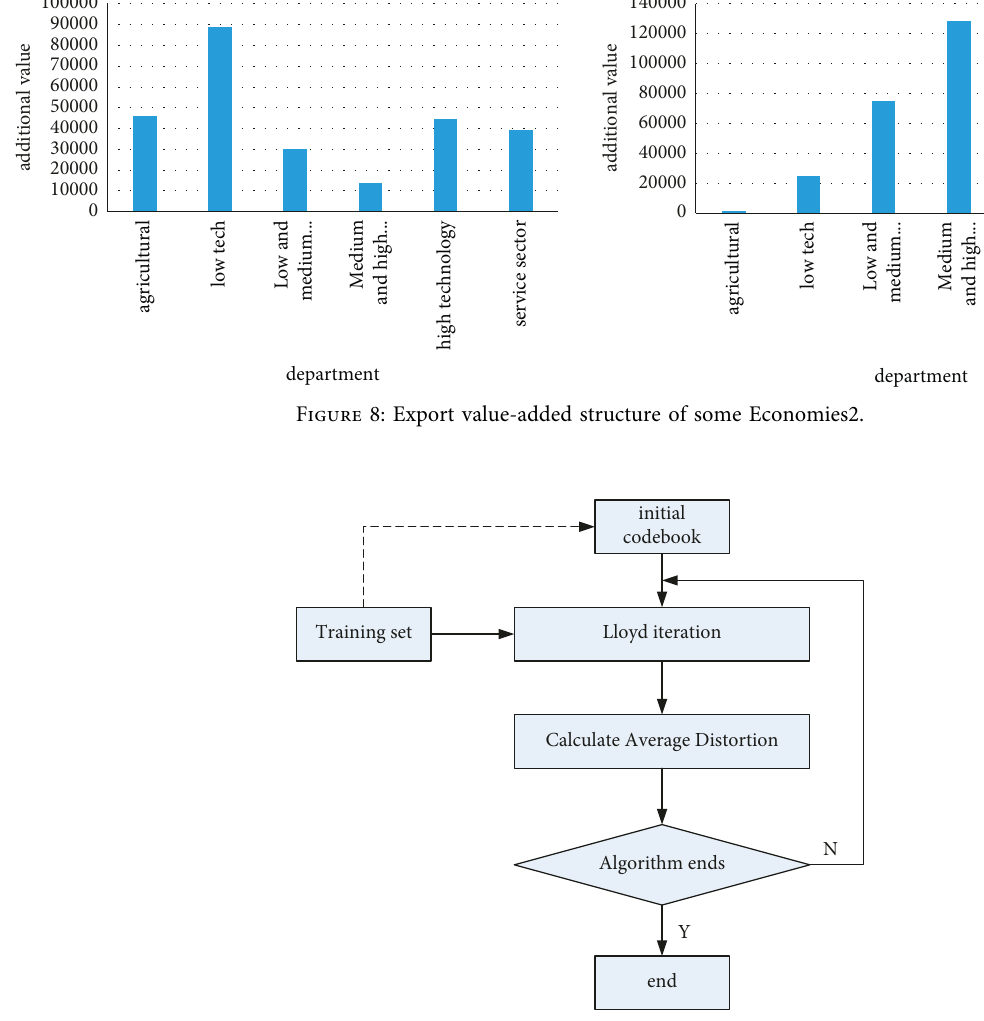
Figure 9: LBG algorithm